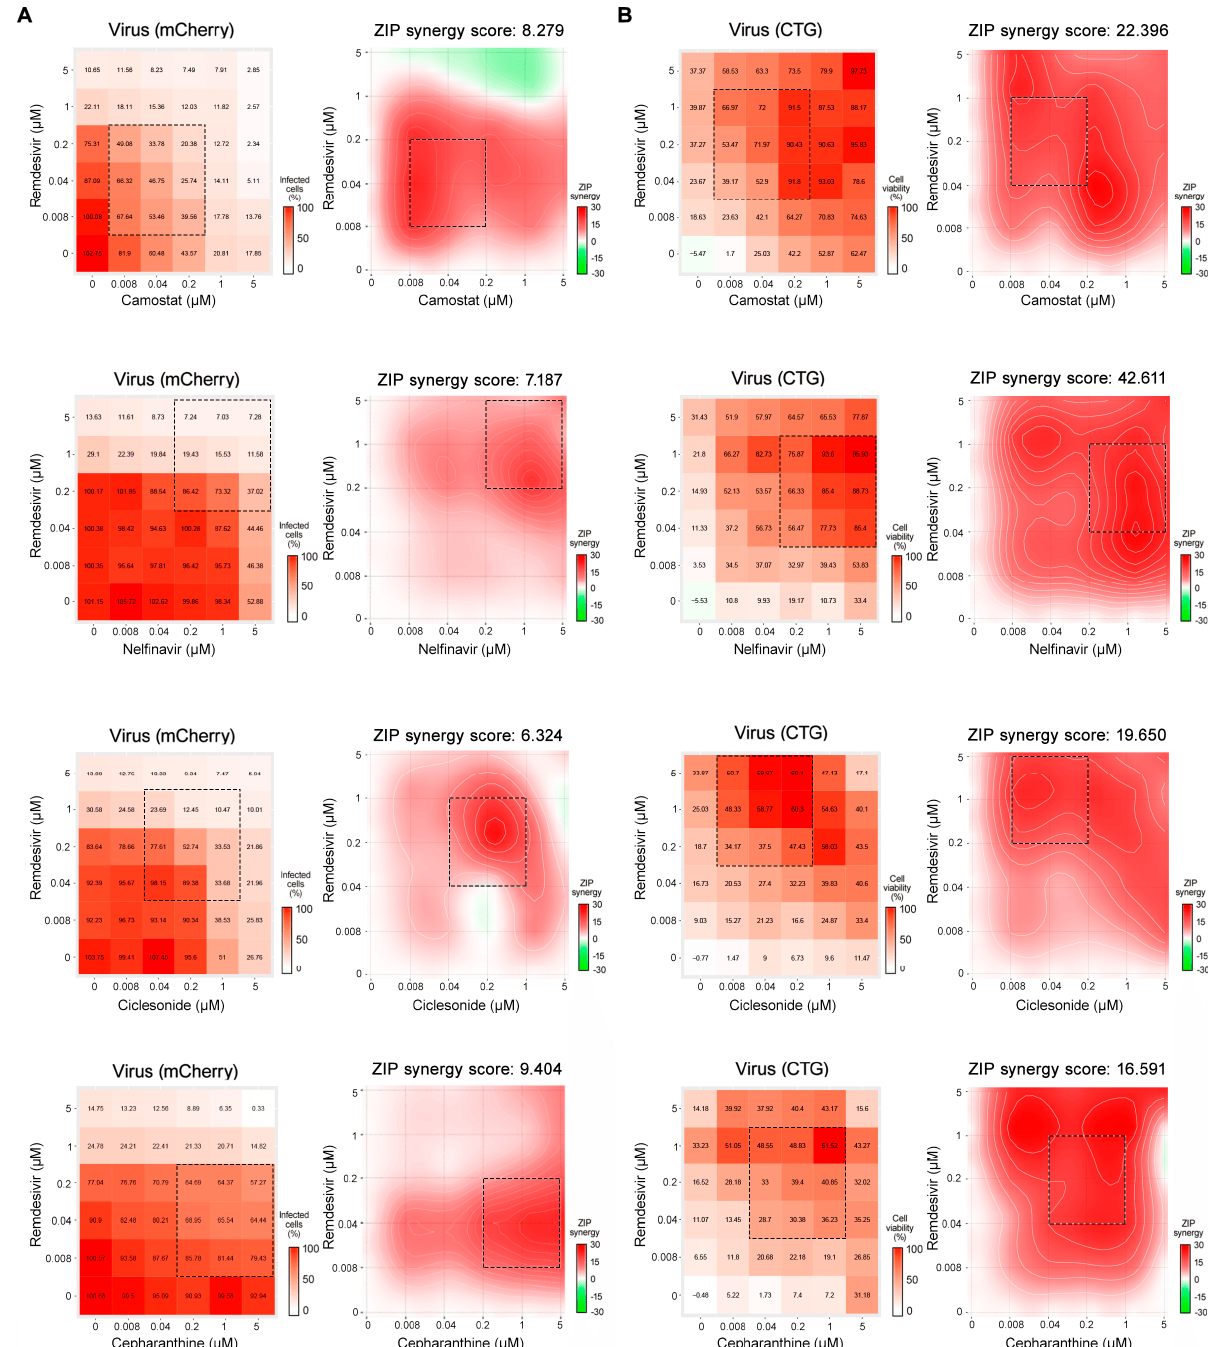
Figure 4. Evaluation of drug combinations in SARS-CoV-2-mCherry-infected Calu-3 cells. ( A ) The 6 × 6 dose–response matrices and interaction landscapes of remdesivir–camostat; remdesivir–nelfinavir; remdesivir–cepharanthine; and remdesivir–ciclesonide obtained using fluorescence analysis of SARS-CoV-2-mCherry-infected Calu-3 cells. ZIP synergy scores were calculated for indicated drug combinations. ( B ) The 6 × 6 dose–response matrices and interaction landscapes of remdesivir–camostat; remdesivir–nelfinavir; remdesivir–cepharanthine; and remdesivir–ciclesonide obtained using a cell viability assay (CTG) on mock-, and SARS-CoV-2-mCherry-infected Calu-3 cells. The selectivity for the indicated drug concentrations was calculated (selectivity = efficacy-(100-Toxicity)). ZIP synergy scores were calculated for indicated drug combinations.